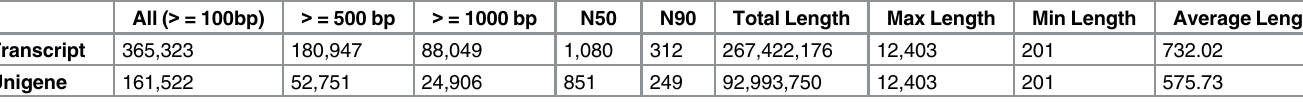
Table 2. The statistics of de novo